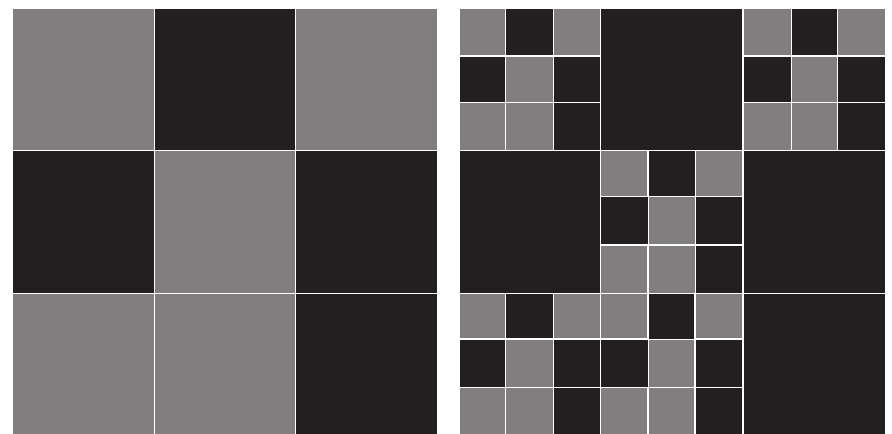
Figure 1: Schematic illustration of the solid mass fractal model with 𝐸 = 2 , 𝑛 = 3 , and 𝑏 = 5 . Gray denotes the iterating phase and black denotes the pore